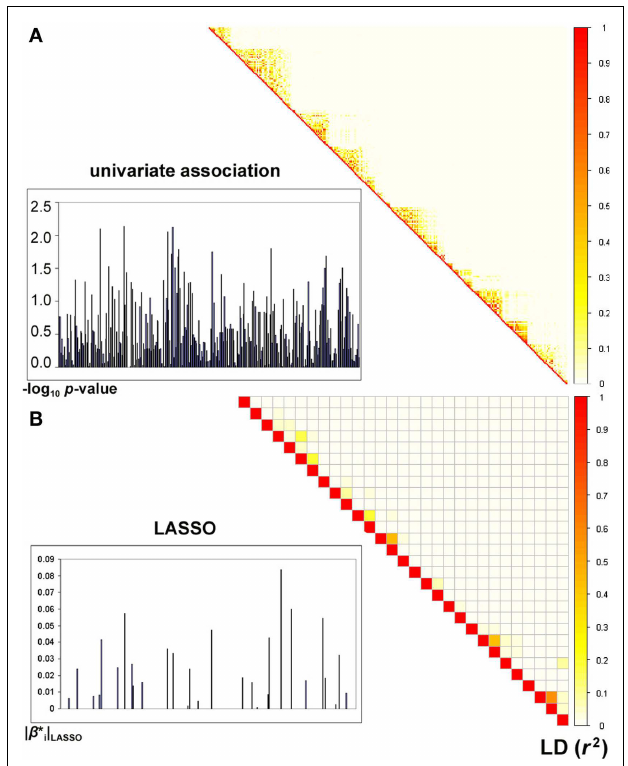
FIGURE 1 | Comparison of univariate and LASSO association tests with an imaging-derived measure of temporal lobe volume. (A) p -values are shown, in the left panel, as − log 10 p (i.e., after logarithmic transformation) for all 291 genotyped SNPs in the MACROD2 gene, using univariate association with temporal lobe volume.The most significant SNP in this gene has a p -value of 7.3 × 10 − 3 . A matrix representing the pairwise correlation (i.e., r 2 ), due to linkage disequilibrium (LD), between the SNPs is displayed in the right panel. (B) LASSO considers all SNPs in a gene jointly and assigns sparse coefficients to the SNPs. Here, the absolute values of | are displayed for all SNPs in MACROD2 , 29 of which the coefficients | β ∗ i attained non-zero coefficients as part of the sparse regression model fitted by the LASSO method.When considered jointly in a multiple linear regression model, the selected SNPs yield a boosted p -value of 7.94 × 10 − 12 for MACROD2 (see Table 1 ). As in (A) , the correlation structure between the selected SNPs is shown, demonstrating reduced